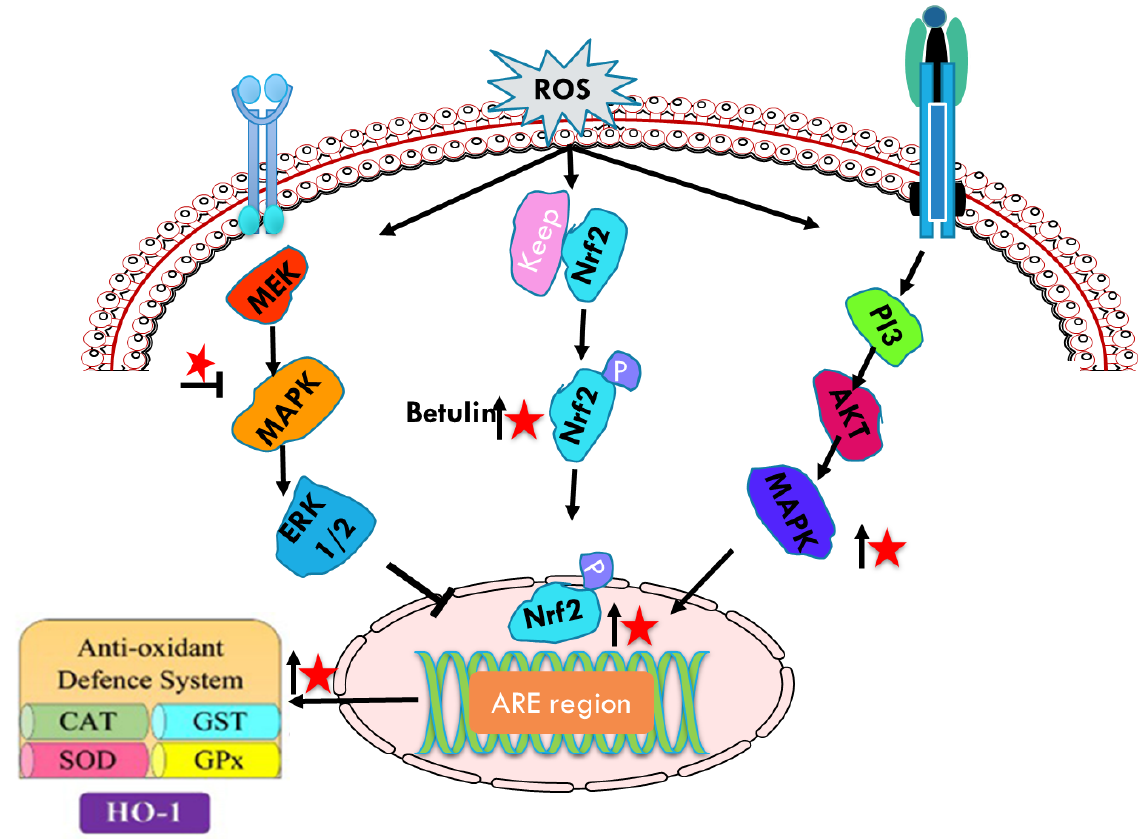
Figure 6. Schematic representations of betulin (represented as red star) mediated modulation (upregulation ↑, downregulation ↓ ) of Nrf 2 phosphorylation and anti-oxidant defense system.